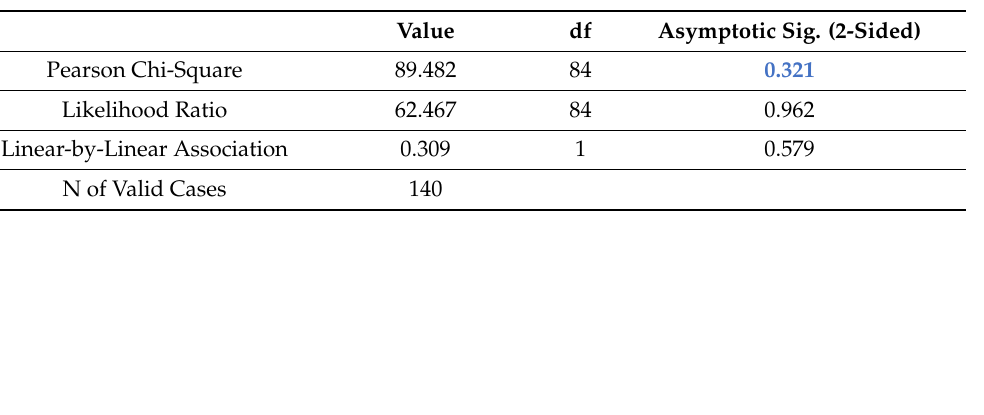
Table 19. The results for Chi-Square bivariate